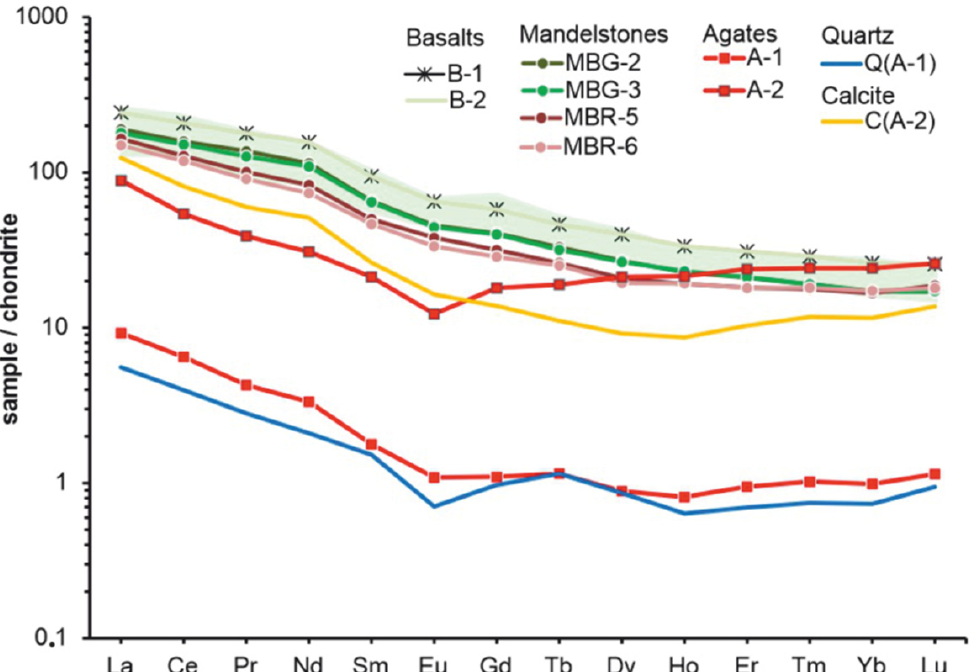
Figure 12. Chondrite-normalized REE distribution patterns for Salmi agates (including quartz and